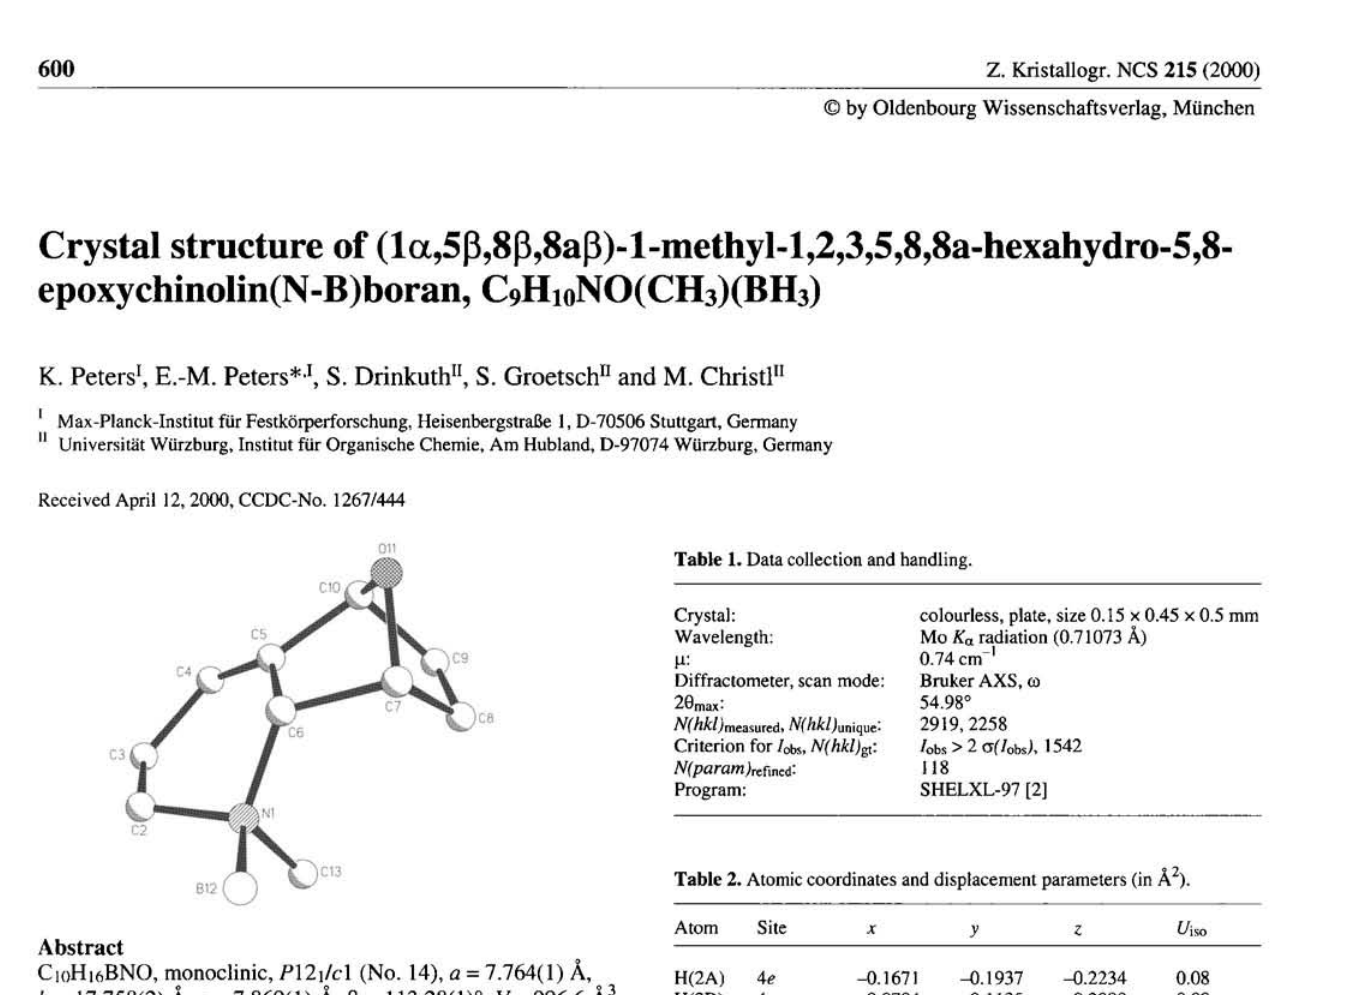
Table 2. Atomic coordinates and displacement parameters (in Â 2